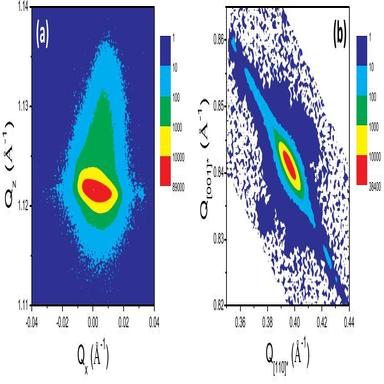
XRD reciprocal space maps from the epitaxial diamond layer on Ir/STO/Si(001) around (a) the (004) node, and (b) the (113) node.